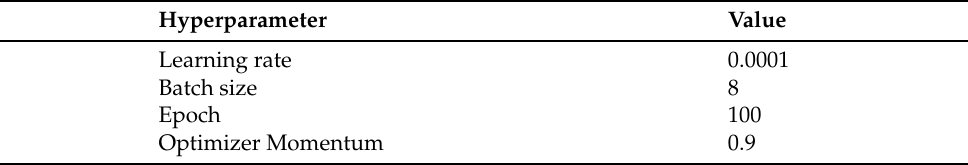
Table 6. Hyperparameter